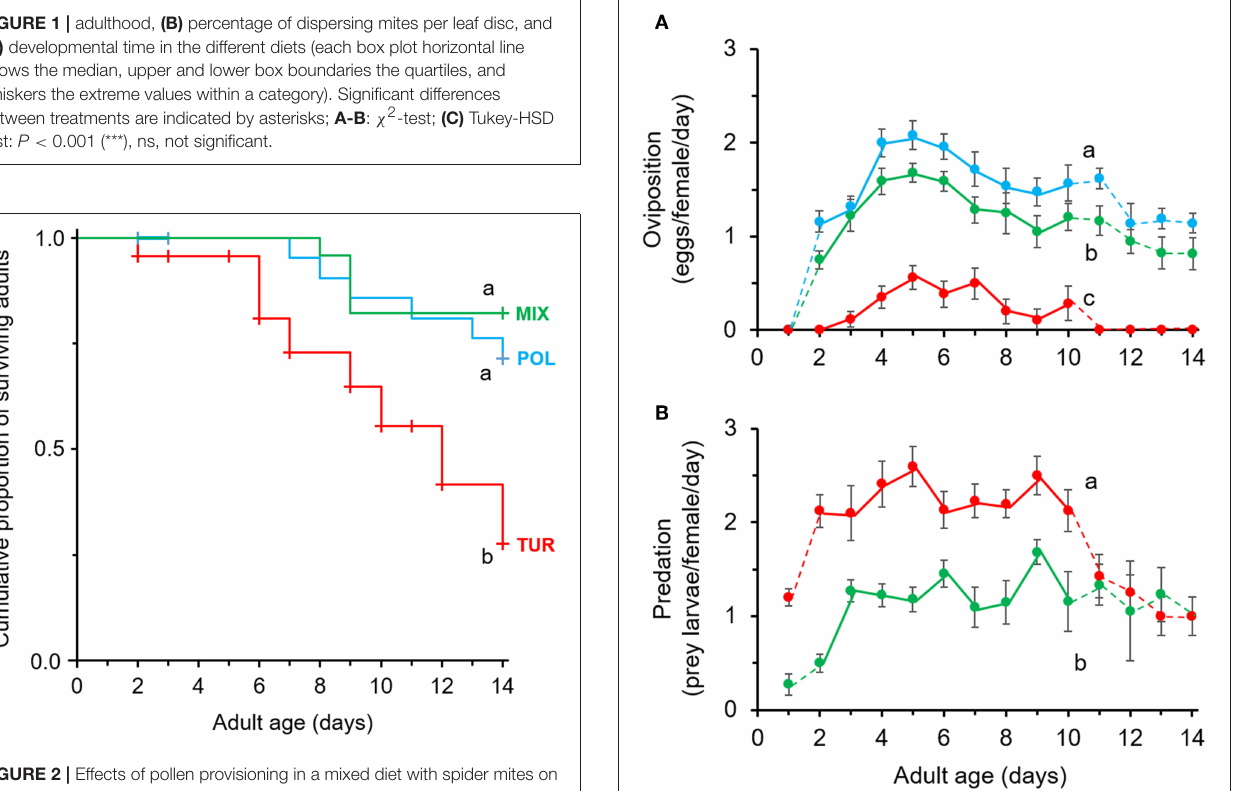
FIGURE 2 | Effects of pollen provisioning in a mixed diet with spider mites on the survival of adult Amblydromalus limonicus . Female adults were feeding on either Typha latifolia pollen (blue line, POL), spider mite larvae (red line, TUR), or a mixed diet consisting of spider mite larvae plus pollen (green line, MIX) for a period of 2 weeks. Shown are Kaplan-Meier survival curves of adults ( n = 25 per treatment) feeding on the different diets. Significant differences between treatments are indicated by different letters by Mantel-Cox log-rank tests ( P < 0.05). Censored observations (dispersing predators) are shown as crosses on the lines.